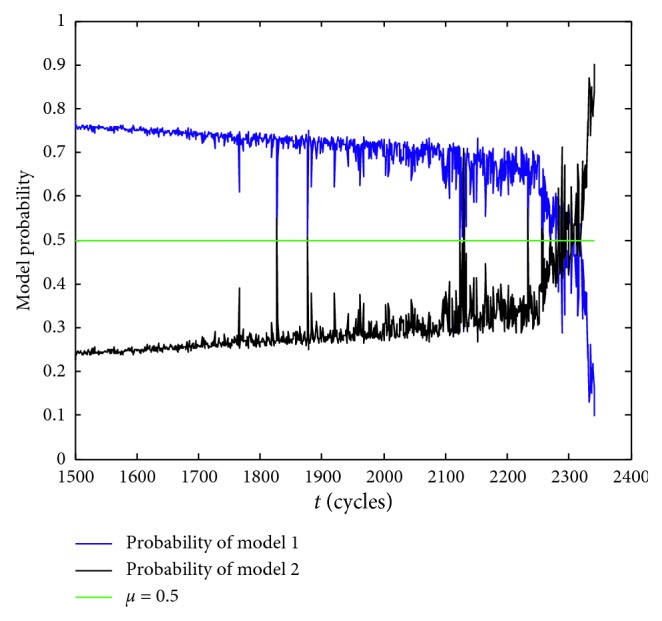
Model probability.